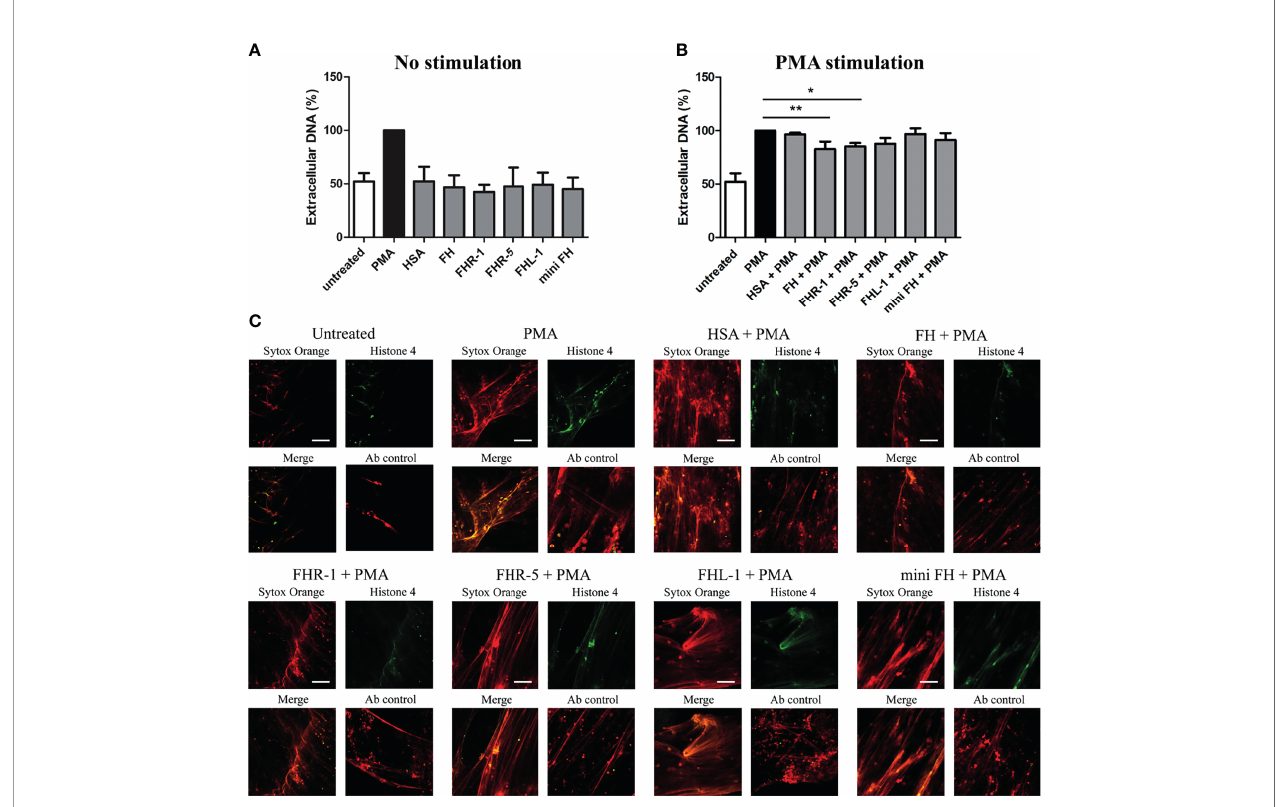
FIGURE 4 | FH and FHR-1 decrease PMA-induced NET formation. 300 nM FH, FHR-1, FHR-5, FHL-1 or mini-FH were immobilized and incubated with neutrophil granulocytes in the absence (A) or presence (B, C) of 100 nM PMA for 3 h. As negative control, HSA-stimulated cells were used. (A, B) Cell-free NET was quanti fi ed by fl uoroscan measurement using Sytox Orange DNA staining. PMA-stimulated samples were set as 100%. Data are means + SD derived from three different donors. Differences with p < 0.05 were considered statistically signi fi cant and compared to PMA treated samples (one-way ANOVA with Dunnett ’ s multiple comparison test, * p < 0.05, ** p < 0.01). (C) Representative microscopic images of NET formation in the presence of PMA on 300 nM immobilized FH, FHR-1, FHR- 5, FHL-1 and mini-FH using a 20× objective. NET formation was visualized by 5 µM Sytox Orange staining and histone H4 labeling. Scale bars represent 100